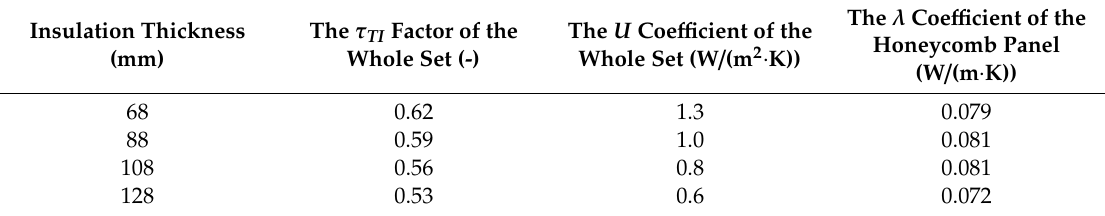
Table 1. Properties of transparent insulation.